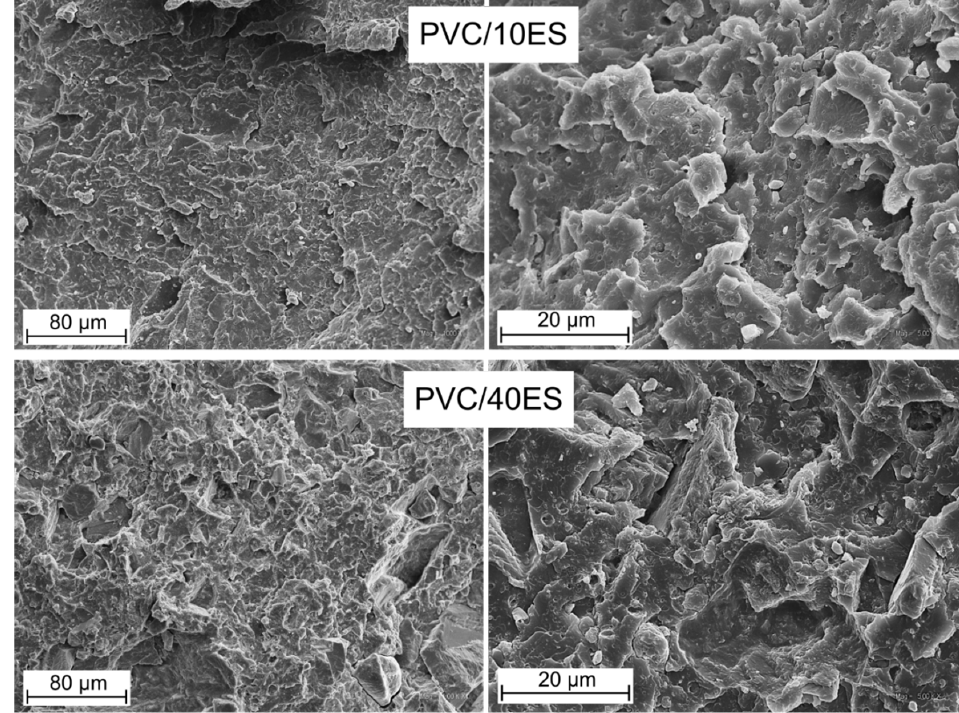
Figure 10. SEM images of the cryogenic breakthroughs of composites containing 10 phr and 40 phr filler of 1 k× and 5 k×.